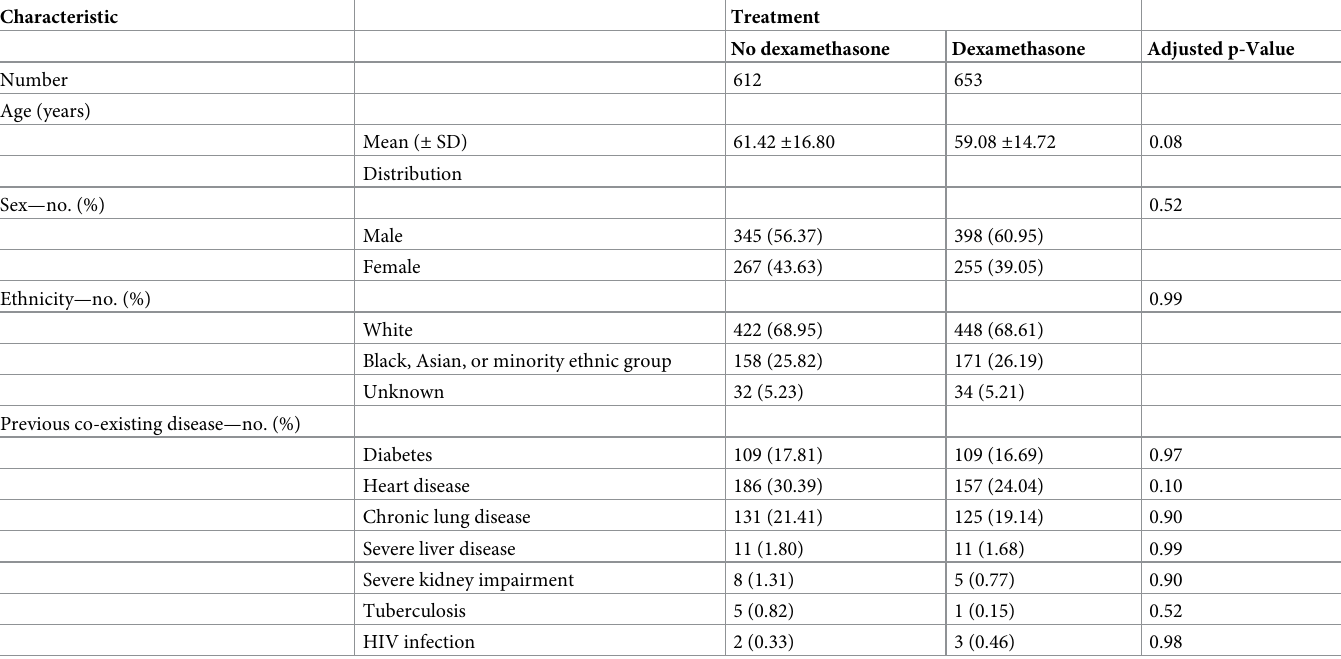
Table 2. Characteristics of the patients with confirmed SARS-CoV-2 severe acute respiratory syndrome coronavirus 2 according to treatment.